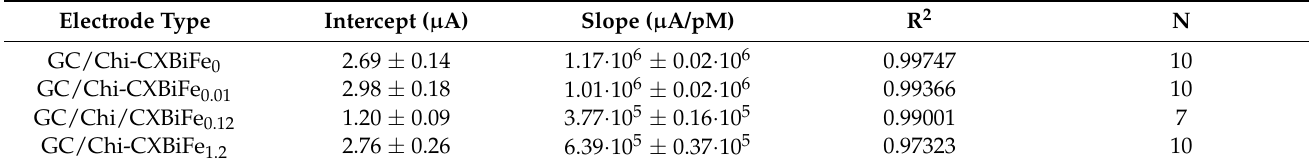
Figure 7. SWASVs recorded at GC/Chi-CXBiFe 0 ( A ) and GC/Chi-CXBiFe 1.2 ( B ) electrodes in the presence and absence of Pb 2+ , and the corresponding calibration curve ( C , D ), respectively. Experimental conditions: supporting electrolyte, 0.1 M acetate buffer (pH 4.5); deposition potential, − 1.4 V vs. Ag/AgCl, KCl sat; deposition time, 180 s; frequency, 10 Hz; amplitude, 25 mV; starting dissolution potential, − 1.2 V vs. Ag/AgCl, KCl sat. Table 6. Linear regression parameters for SWASV detection of Pb 2+ at CXBiFe x nanocomposites modified glassy carbon electrodes.